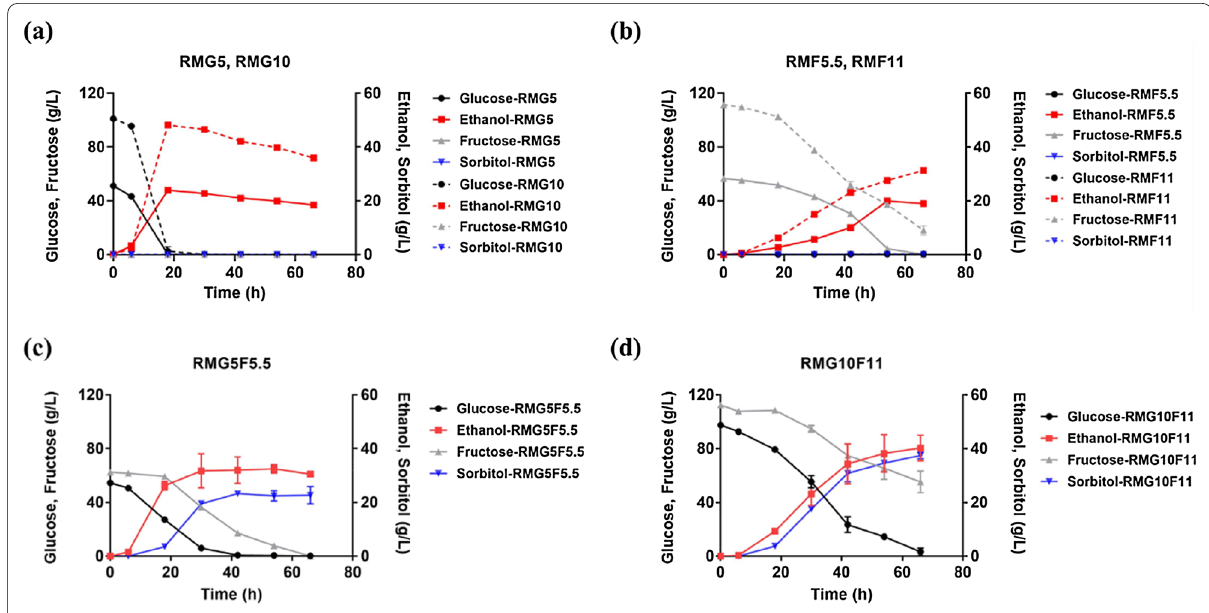
Fig. 1 Fermentation performance of Z. mobilis in RM medium including the consumption of glucose (black circle) and fructose (grey triangle) as well as the production of ethanol (red square) and sorbitol (blue inverted triangle) in RMG5 and RMG10 ( a ), RMF5.5 and RMF11 ( b ), RMG5F5.5 ( c ), and RMG10F11 ( d